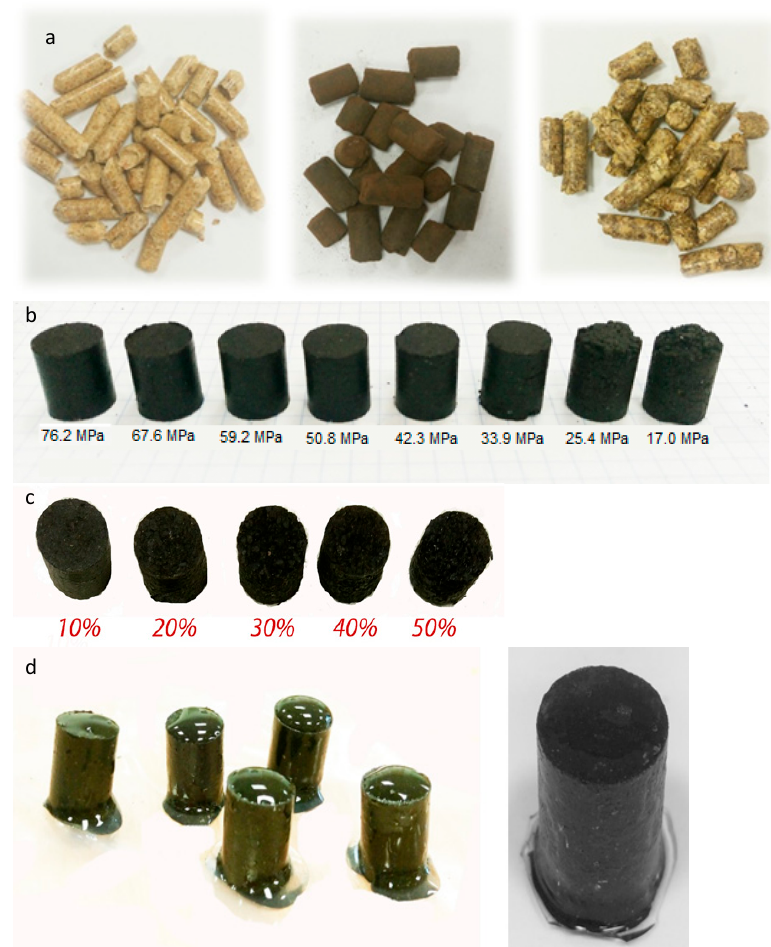
Figure A1. Pellets tested in the experiment: ( a ) reference pellets from biomass: pine (left), lignocellulosic (middle), from corn husks (right); ( b ) carbonized refuse-derived fuel (CRDF) pellets produced by applying pressure from 17.0 MPa to 76.2 MPa; ( c ) CRDF pellets produced with a pressure of 50.8 MPa and a variable proportion of water glass from 10% to 50%; ( d ) CRDF pellets produced with a pressure of 50.8 MPa impregnated with water glass: left: samples immediately after impregnation, right: sample after drying.